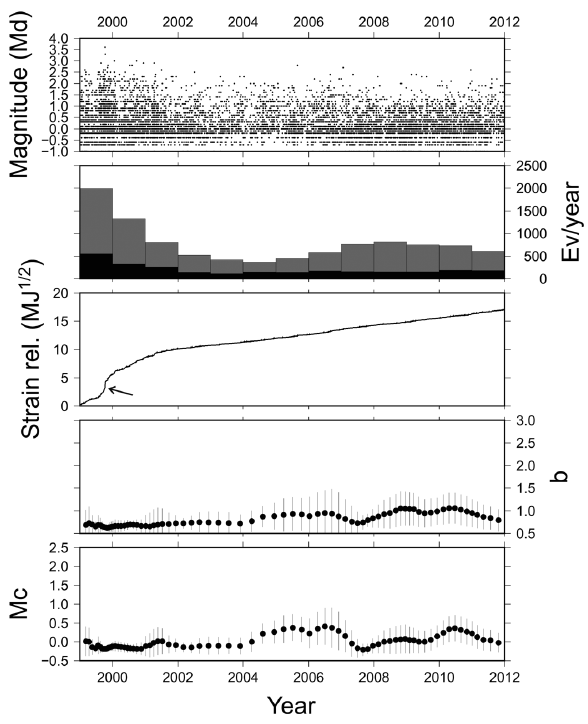
for the two models. See Section 2 for details. Table 2. b-value and M c